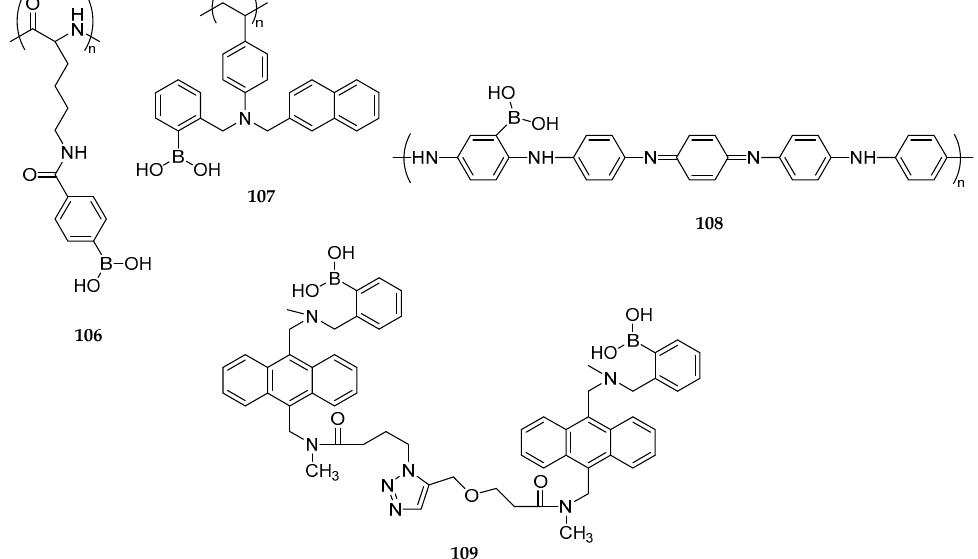
Figure 10. Boronic acid derivatives as sensors. 106 : Poly(L- and D-lysine) with phenylboronic acid as a glucose sensor; 107 : Boronic acid derivative with a fluorophore for saccharide sensing; 108 : Poly(aniline boronic acid) polymer as a dopamine sensor; 109 : Anthracene-based diboronic acid, an oligosaccharide sensor.